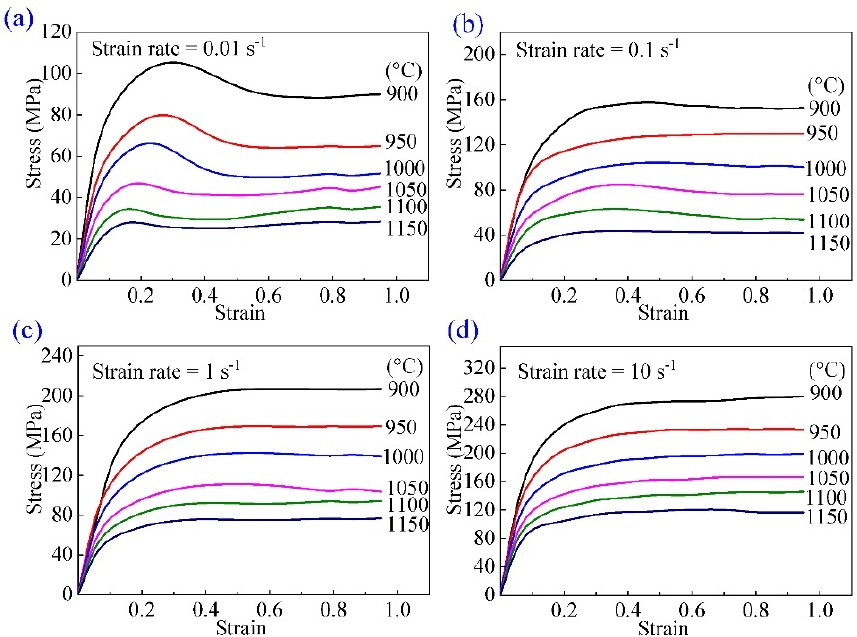
− 1 , ( b ) 0.1 s − 1 , ( c ) 1 s − 1 , and ( d ) 10 s − 1